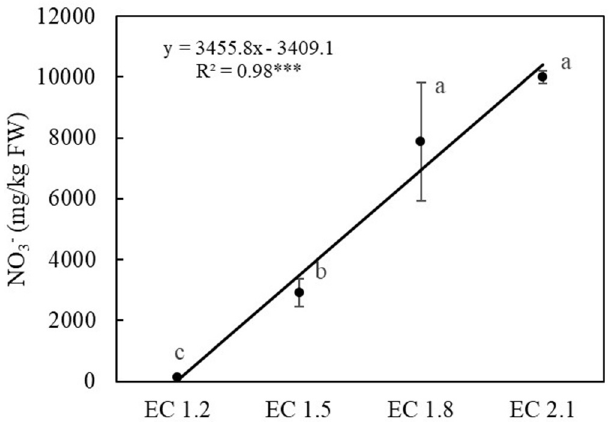
Figure 10. Effect of electrical conductivity (EC) of nutrient solution on the nitrate concentration of arugula leaves 4 weeks after transplanting into a nutrient-film technique hydroponic system containing nutrient solutions with EC of 1.2, 1.5, 1.8, or 2.1 dS · m − 1 . Data points with different letters are significantly different according to Tukey’s test ( α = 0.05). Error bars represent the standard errors ( n = 32). *** indicatea significance at p